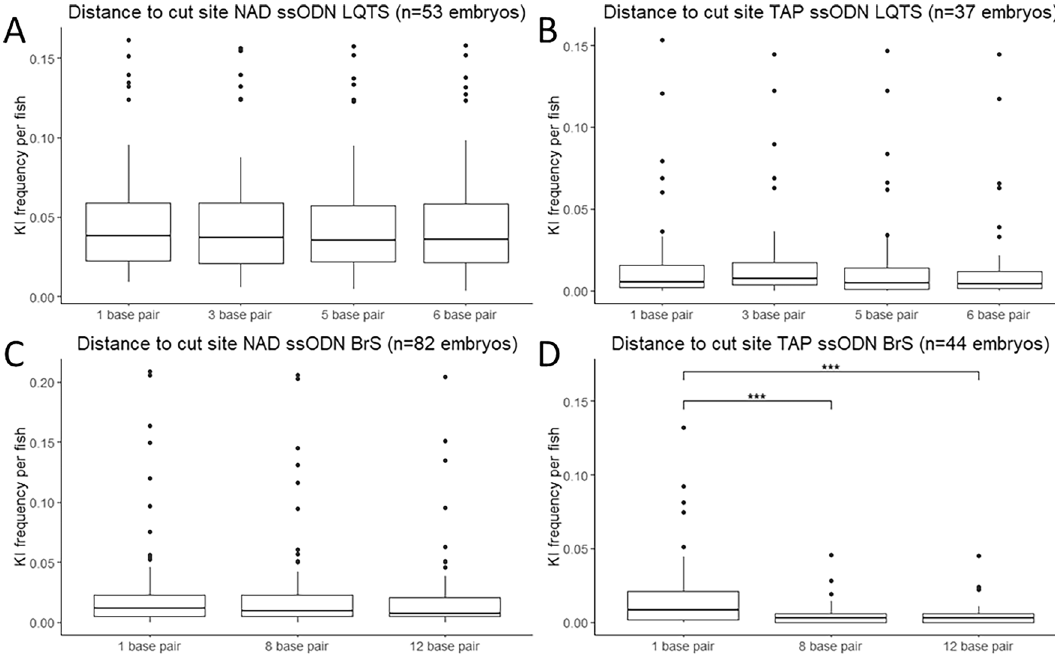
Figure 3. Effect of distance to the cut site on KI efficiency. ( A ) Frequency of KI per embryo for the non-target asymmetric PAM distal ssODN conformation for the LQTS locus (n = 37). ( B ) Frequency of KI per embryo for the target asymmetric PAM proximal ssODN conformation for the LQTS locus (n = 53). ( C ) Frequency of KI per embryo for the non-target asymmetric PAM distal ssODN conformation for the BrS locus (n = 82). ( D ) Frequency of KI per embryo for the target asymmetric PAM proximal ssODN conformation for the BrS locus (n = 44). Statistical testing was performed with negative binomial regression with use of the Tukey’s HSD (honestly significant difference) test for multiple correction, not significant results are not displayed, ***p-value < 0.001, **p-value < 0.01, *p-value < 0.05. KI knock-in, NAD non-target asymmetric PAM distal, TAP target asymmetric PAM